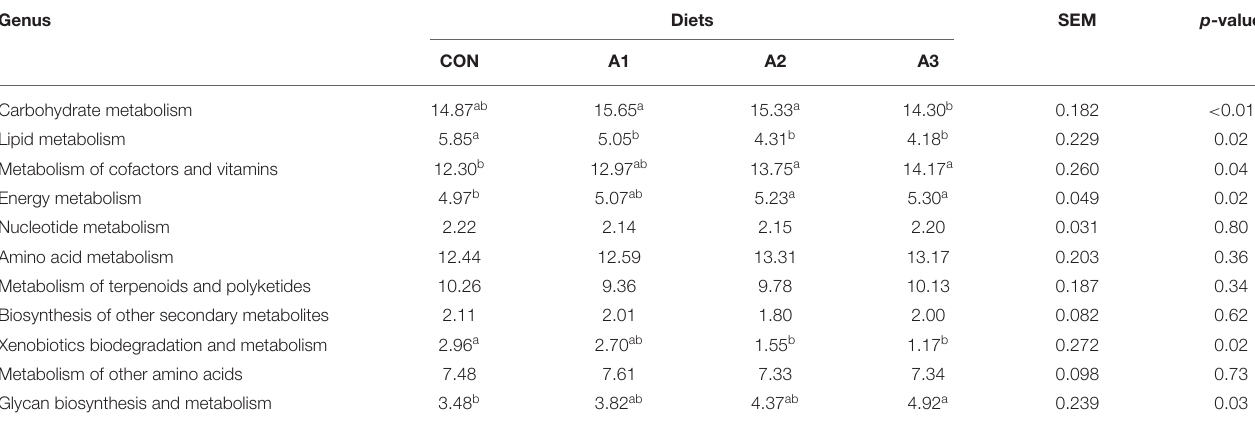
TABLE 8 | Effects of Anemoside B4 on metabolism of suckling calves at 28 days of age (%). Genus Diets SEM p -value CON A1 A2